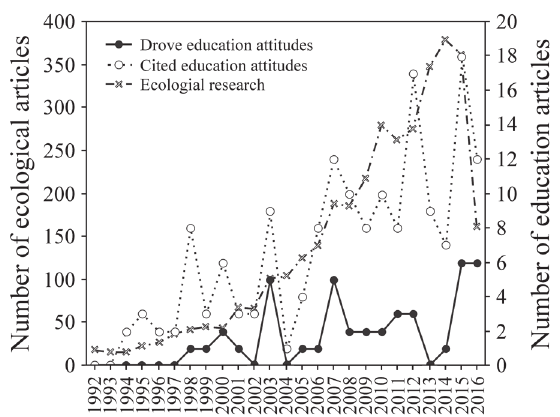
Figure 1 - Record trends to ecological and education articles from 1992 to July